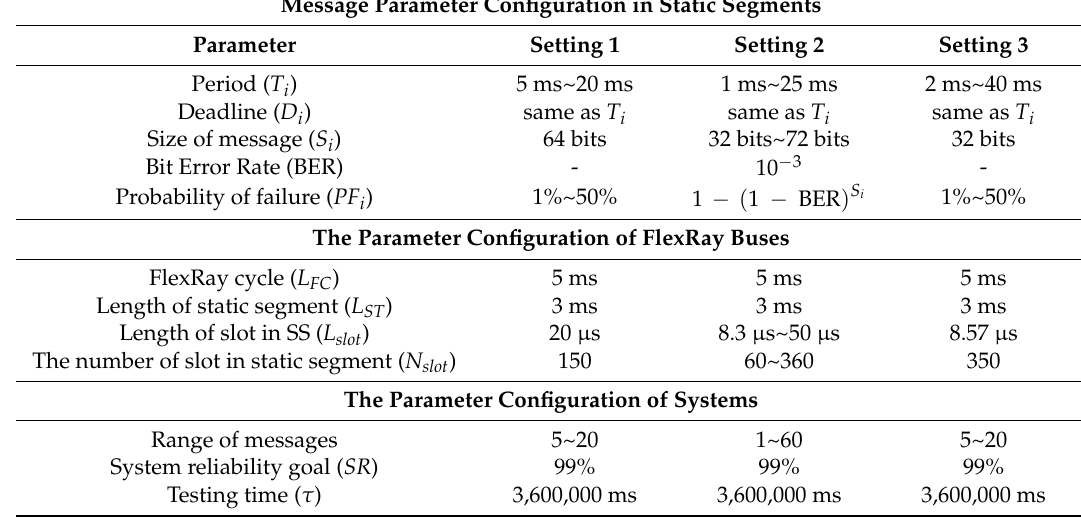
Table 2. The parameter settings of related work.